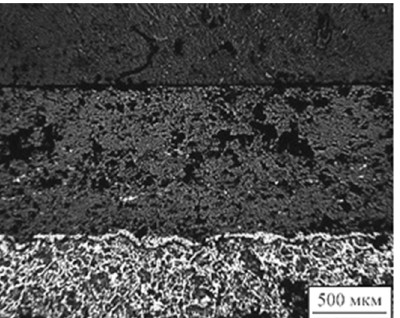
Figure 14. Microstructure of laser spraying (micrographs obtained using an optical microscope).